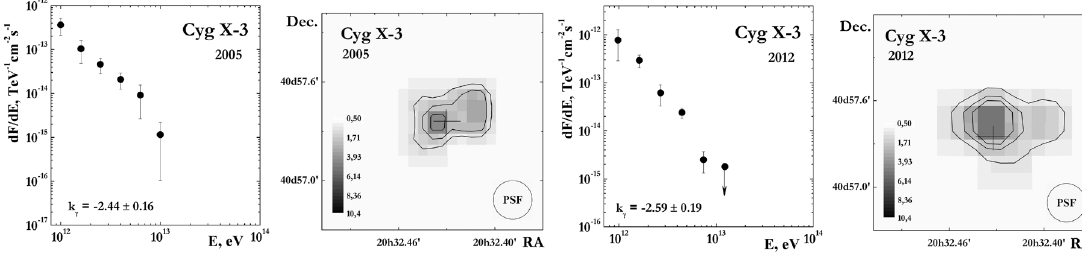
Figure 7. Di ff erential spectra and images of the γ -ray emission of Cyg X-3 at E > 0 . 8 TeV in the quiescent periods of 2005 and